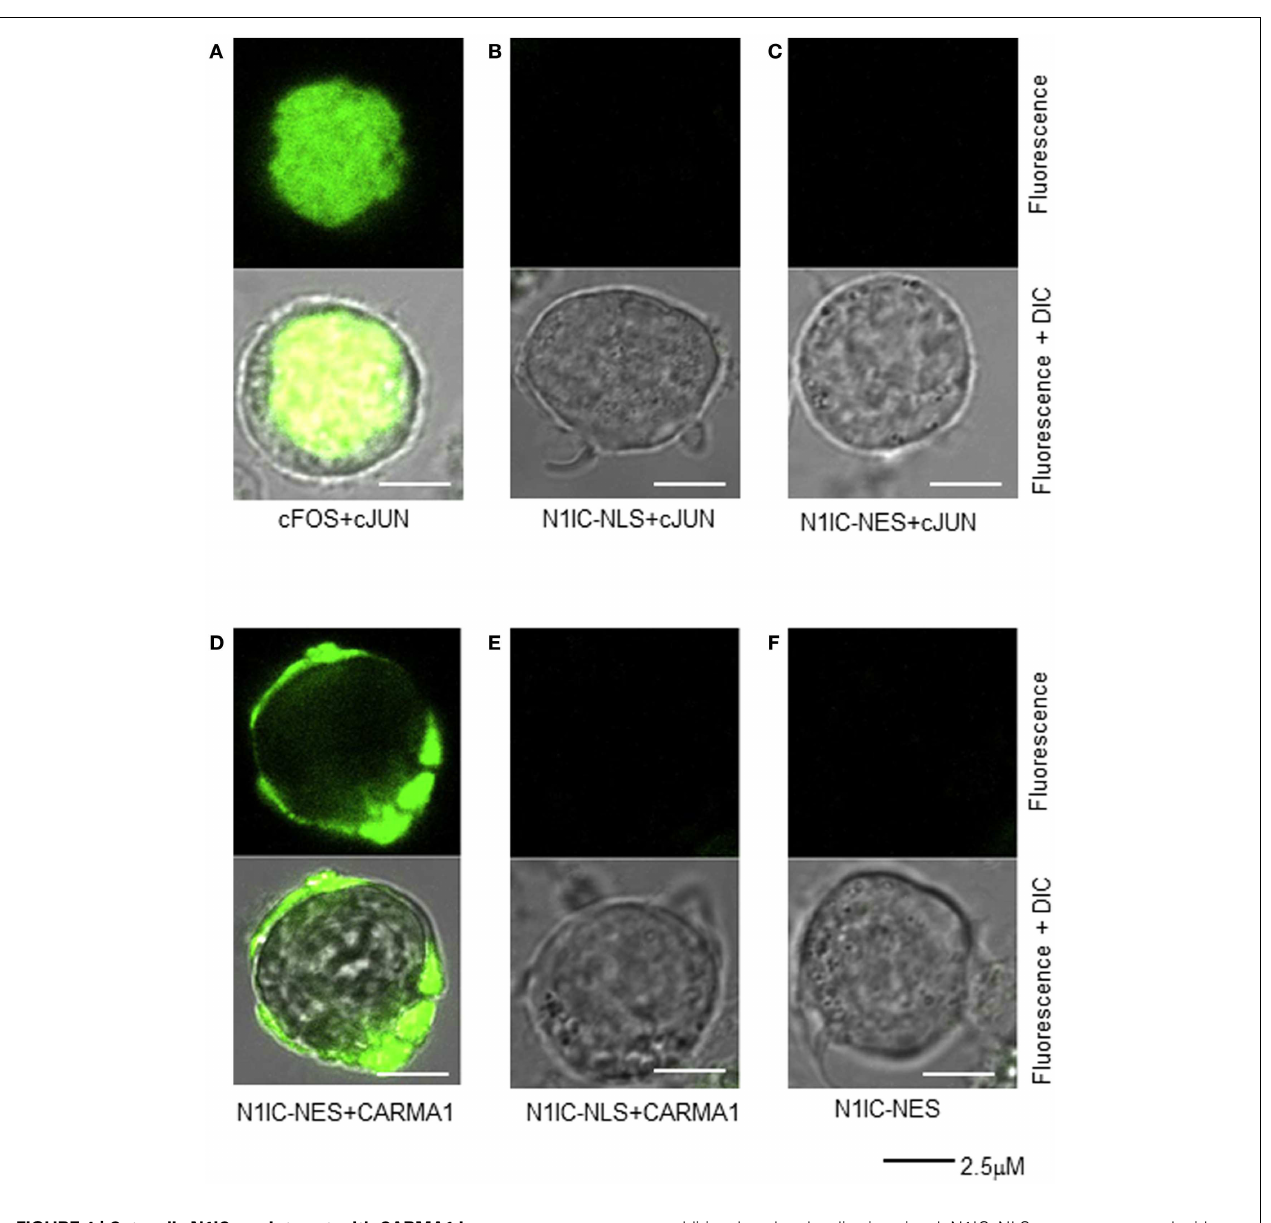
FIGURE 4 | Cytosolic N1IC can interact with CARMA1 in a bifluorescence complementation assay . JurkatT cells were transfected with various constructs of nuclear and/or cytosolic proteins and their physical association was assessed microscopically by their ability to reconstitute two halves of a yellow fluorescent protein reporter. Twenty-four hours after transfection, cells were plated onto glass bottom culture dishes, stimulated with anti-human CD3 ε and anti-human CD28, and fluorescent images of live cells were captured using a Zeiss LSM 510 confocal microscope. (A) Nuclear proteins, cFos and cJun, known to interact in the nucleus were co-expressed as a control; (B) NOTCH1 with